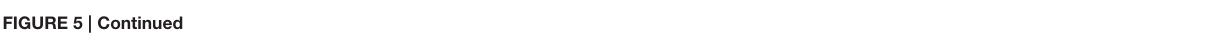
FIGURE 5 | Continued WT control seedlings grown on MS medium plates. Error bars mean SE of three biological replicates. Asterisks indicate statistically significant differences between WT control and OsCYP21-4 OE transgenic plants (Student’s t -test: * p < 0.1 , ** p < 0.01 ). (E) In situ H 2 O 2 accumulation in plants shown in (D) was detected by 3,3 ′ -diaminobenzidine (DAB) staining. The experiments were repeated twice with similar results obtained in each experiment. (F,G) Relative peroxidase and ascorbate